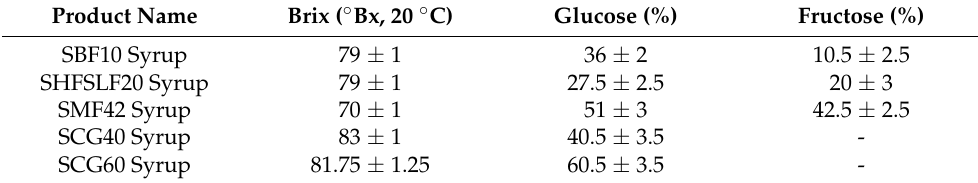
Table 3. Specifications of corn syrups.